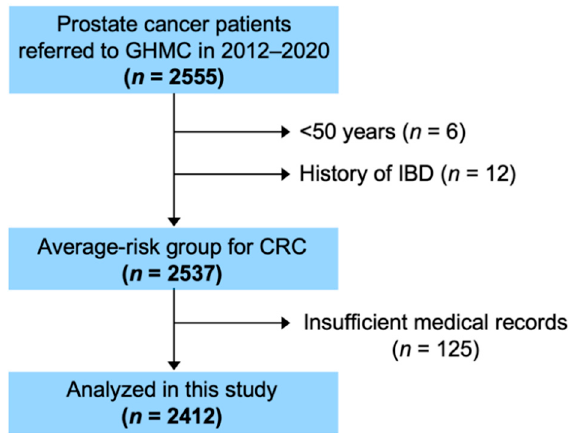
Figure 1. Flow diagram showing patient enrollment. GHMC, Gunma University Heavy Ion Medical Center; IBD, inflammatory bowel disease; CRC, colorectal